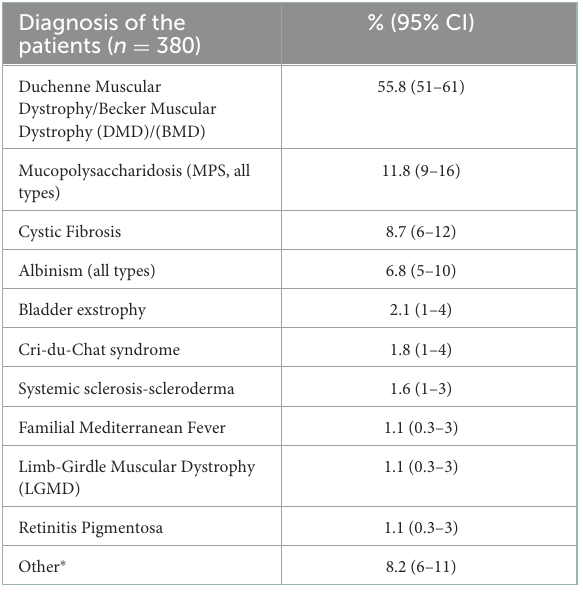
TABLE 1 The profile of the patients. TABLE 2 The diagnoses of the survey